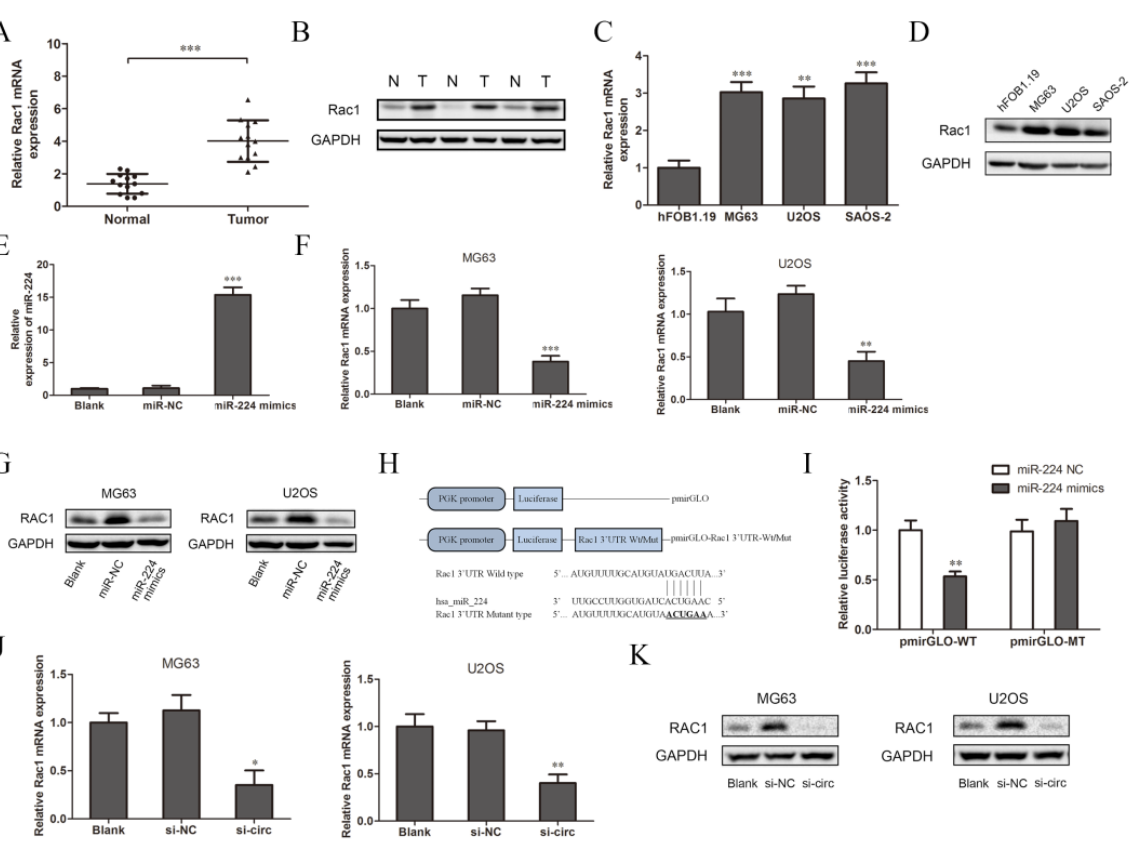
Figure 4. CircSRSF4 served as a ceRNA for miR-224 to regulate the expression of Rac1. ( A ) Relative expression of Rac1 mRNA in OS tissues and corresponding paracancerous tissues. ( B ) Expression of Rac1 in OS tissues and corresponding paracancerous tissues. ( C ) Relative expression of Rac1 mRNA in OS cell lines. ( D ) Expression of Rac1 in OS cell lines. ( E ) Expression of miR-224 in cells transfected with miR-224 mimics. ( F ) Relative expression of Rac1 mRNA in OS cell lines transfected with miR-224 mimics. ( G ) Expression of Rac1 in OS cell lines transfected with miR-224 mimics. ( H ) The structure of the pmirGLO-Rac1-3’UTR-WT/Mut recombinant vector. ( I ) Dual-luciferase reporter gene assay showed that miR-224 could bind to Rac1. ( J ) Relative expression of Rac1 mRNA in OS cells transfected with circSRSF4 siRNA. ( K ) Expression of Rac1 in OS cell lines transfected with circSRSF4 siRNA. * p < 0.05, ** p < 0.01, *** p <